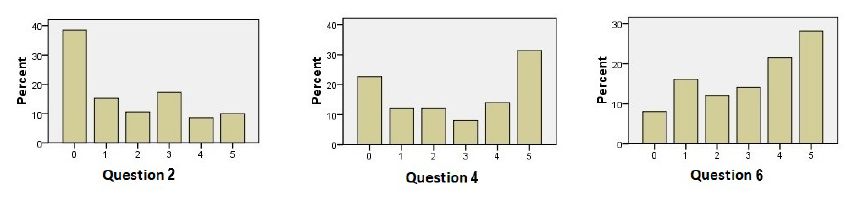
Figure 3: Equal-area